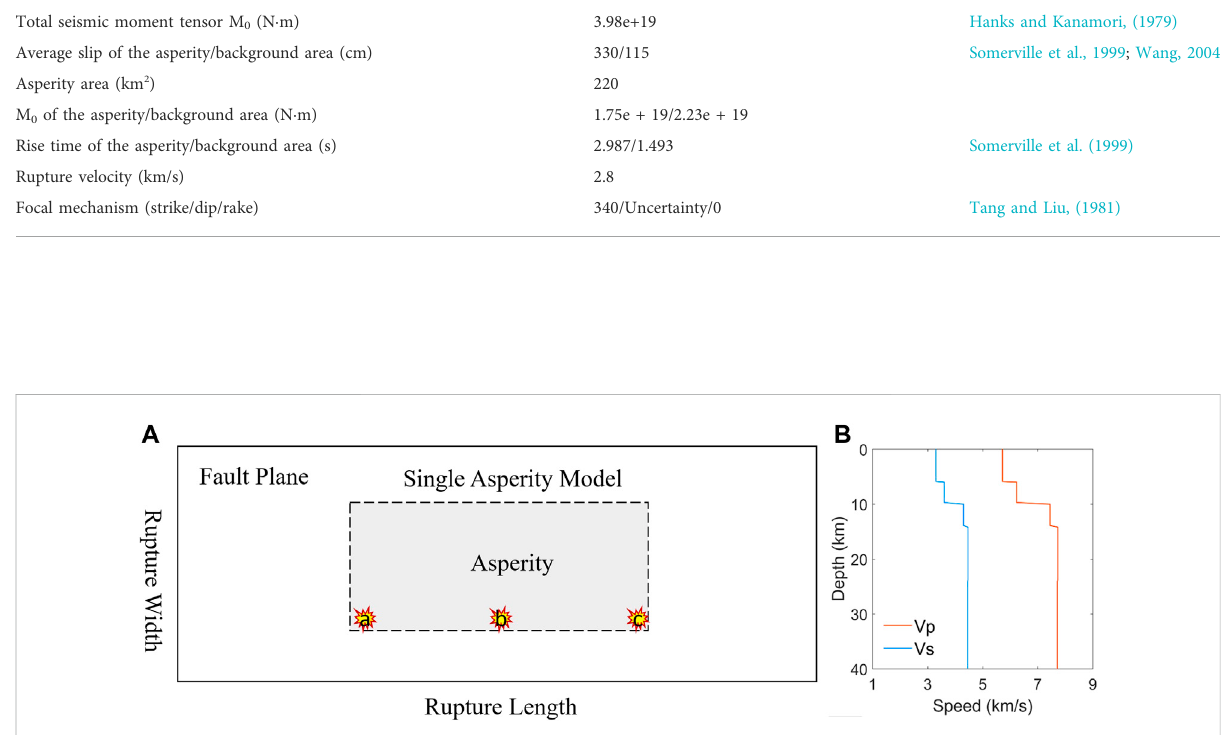
FIGURE 4 Asperitysourcemodelandcrustalvelocitystructureusedforsynthesizinglow-frequency groundmotion (A) Asperitysourcemodelofthelow- frequency ground motion (B) Velocity structure of the low-frequency ground motion.